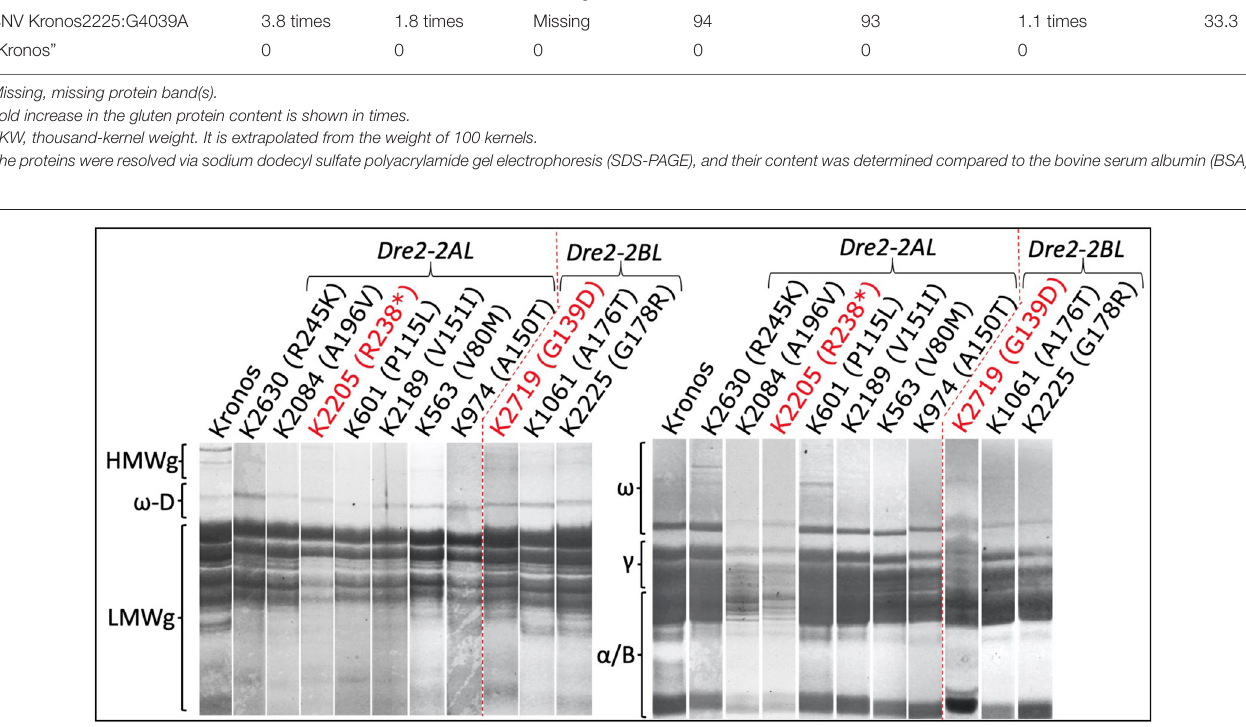
site variation, or premature stop codon), their respective DME active site locations, and their gluten profiles. F 2 seeds were obtained for three combinations in the “Kronos” background and four combinations in the “Express” background